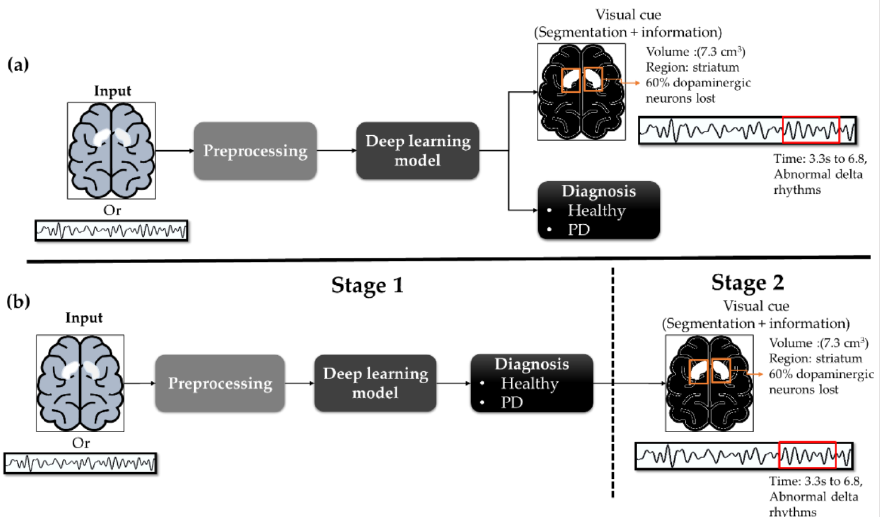
Figure 15. ( a ) configure a deep learning model that can perform the diagnosis (i.e., identification of the ailment) and seg-mentation (i.e., explanation, or detailed information) simultaneously; ( b ) perform diagnosis in the first stage, and in the second stage, segmentation is performed only on the input image or signal that had been diagnosed as PD in the first stage.